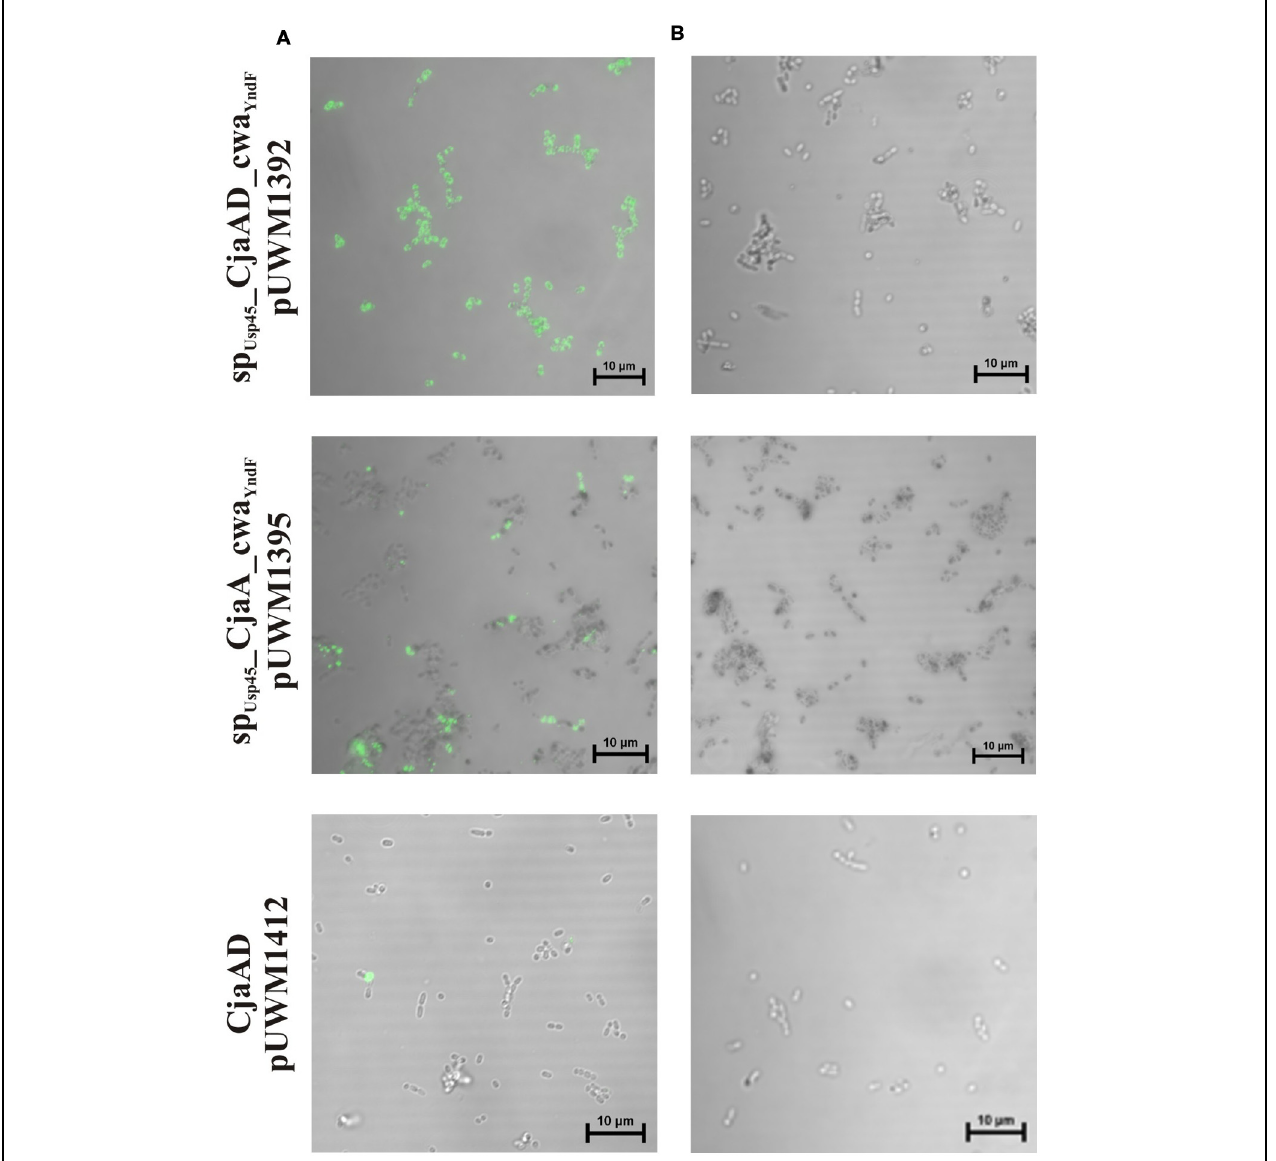
FIGURE 6 | Localization of SP Usp45 _rCjaAD_CWA YndF , SP Usp45 _CjaA_CWA YndF and CjaA proteins on L. lactis IL1403 cells. Microscopic observations of the L. lactis strains expressing the fusion genes: sp Usp45 _rcjaAD_cwa YndF , sp Usp45 _cjaA_cwa YndF and rcjaAD . (A) Shows bacterial cells whose fusion proteins were visualized with anti-CjaA or anti-rCjaAD antibodies that were further detected with goat anti-rabbit IgG Alexa Fluor A488. (B) Primary antibodies were omitted (negative controls). Fluorescence was visualized with a NIKON A1R MP microscope. The bar represents 10 μ m.